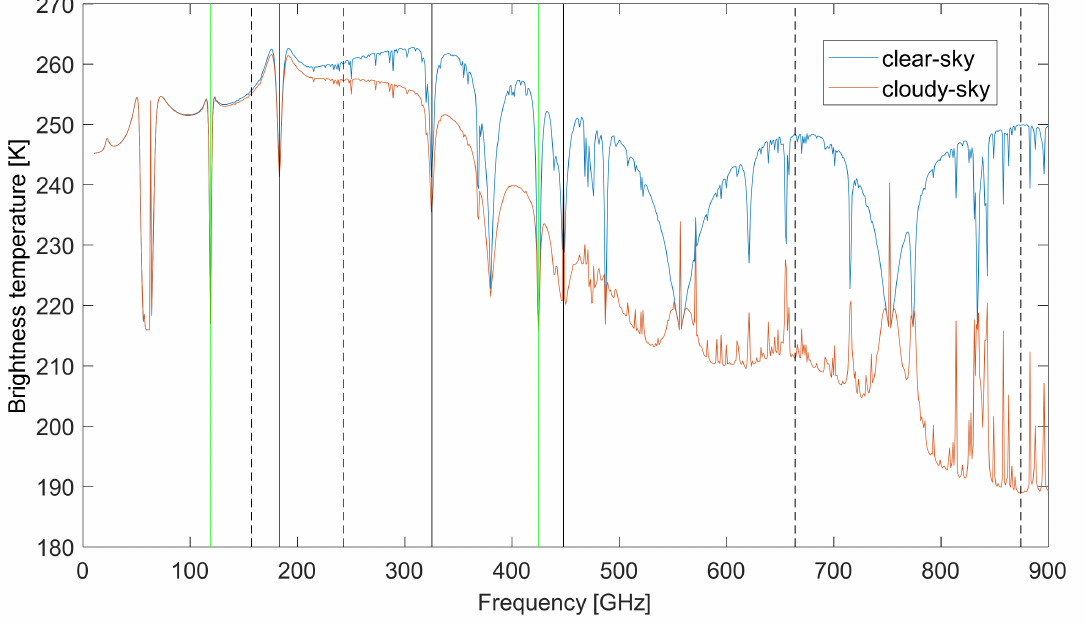
Figure 1. Nadir brightness temperature detected under the clear-sky and ice cloudy-sky. the solid black lines are the water vapor absorption channels, the solid green lines are the oxygen absorption channels, the dashed lines are the window